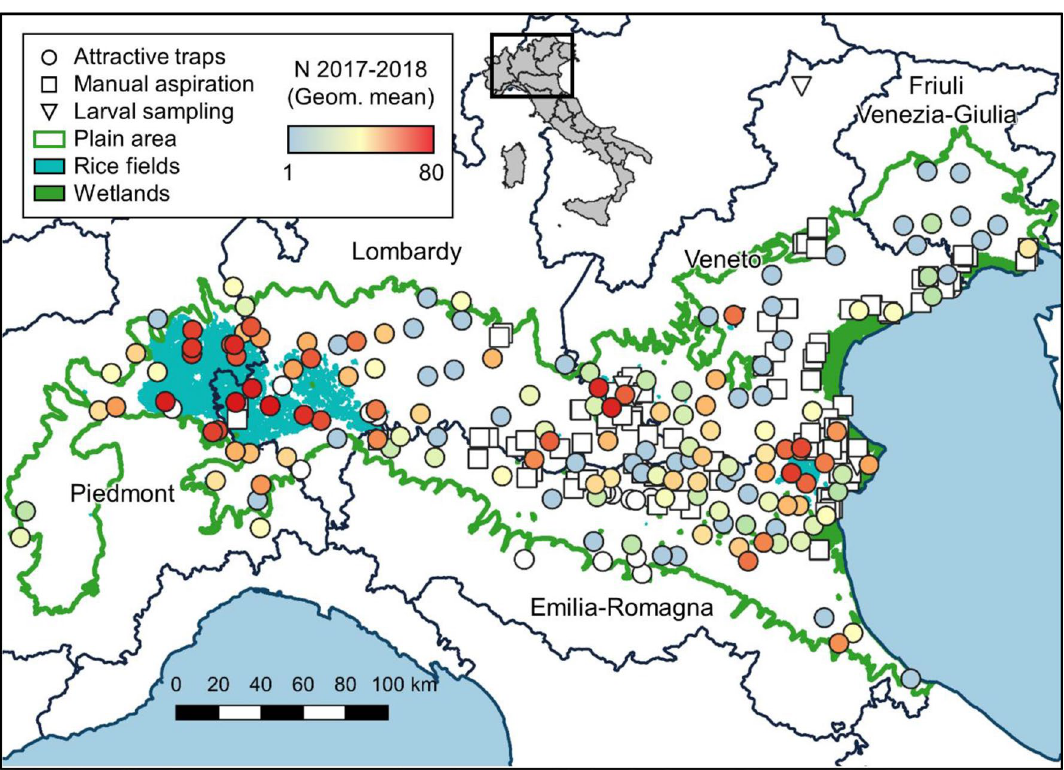
Figure 1. Location of sampled sites on the Northern Italy map, with reference to the boundaries of the Pianura Padana, type of sampling and the geometric mean of mosquitoes of the Maculipennis complex collected per night in the 2017–18 seasons. Map created using QGIS 3.10 (www. qgis.